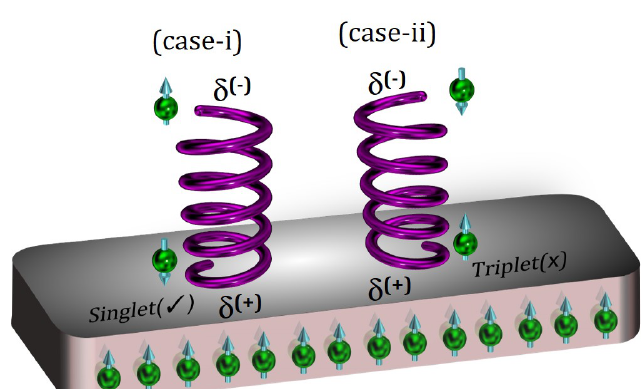
Figure 1. Scheme shows interaction of chiral molecules and ferromagnetic surface. In the first case where spin polarized molecule comes in contact with spin aligned ferromagnet and singlet state forms, where probability of molecule to get adsorbed on the surface is higher. In the second case, spin of the unpaired electron is parallel to the spins in the FM forms triplet state and have lower chance to get adsorbed. δ :